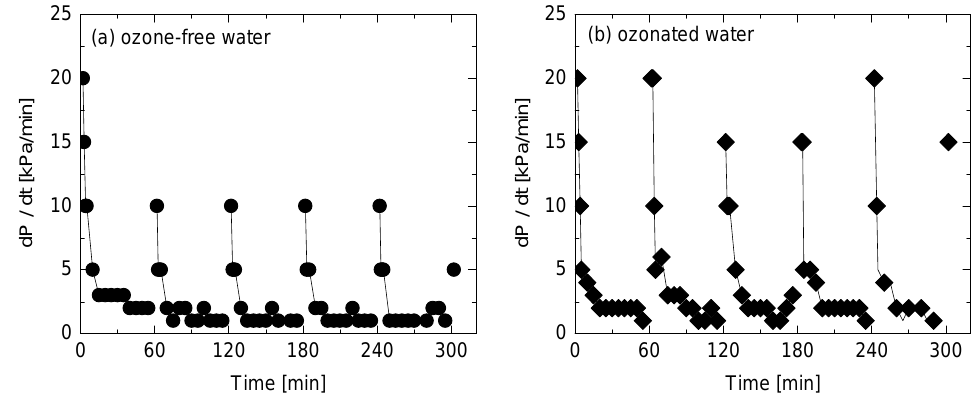
Figure 6. Differential TMP ( dP / dt ) during NF filtration of the secondary wastewater effluent and surface flushing with ( a ) ozone ‐ free and ( b ) ozonated water.